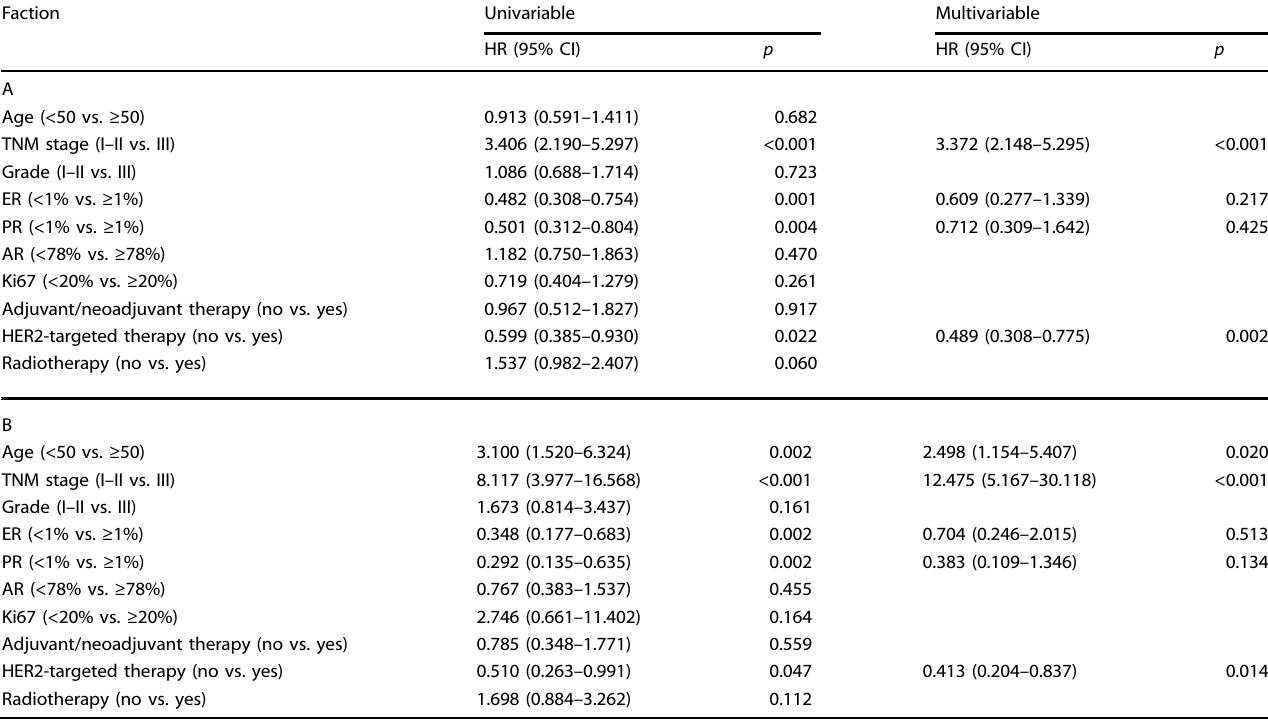
Table 4. Cox proportional hazard regression analysis of DFS (A) and OS (B) in HER2 + breast IDC patients with AR cut-off of 78%. Faction